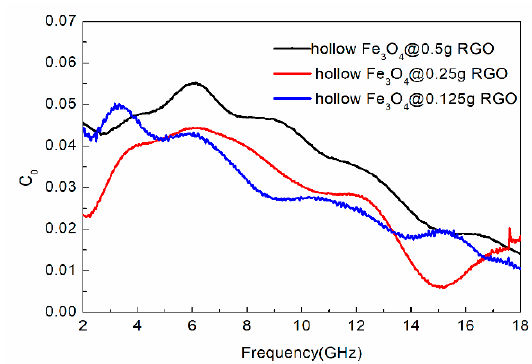
Figure 8. The C 0 - f curve of the hollow Fe 3 O 4 @RGO composite.